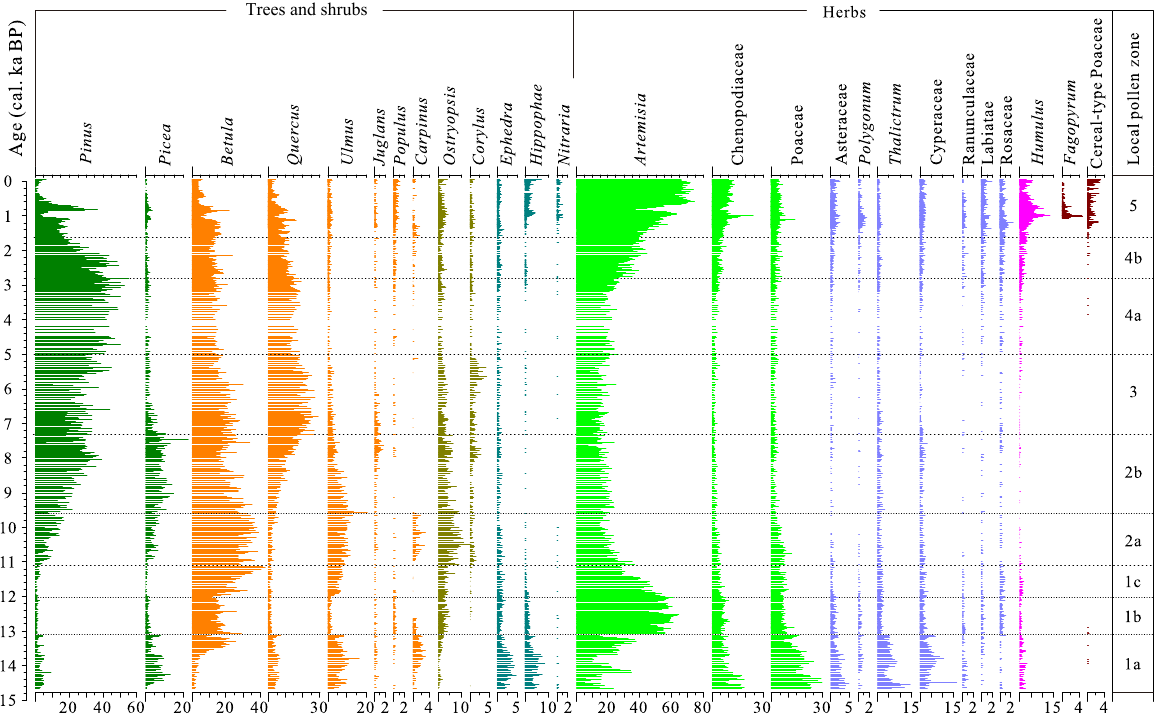
Figure 2. Simplified pollen percentage diagram of core GH09B from Lake Gonghai. The local pollen zone (and subzone) boundaries are based on the results of a constrained cluster analysis with the CONISS programme in Tilia software (Grimm, 1987, 2011) used to make the pollen diagram. The detailed information on vegetation succession was presented in Xu et al.